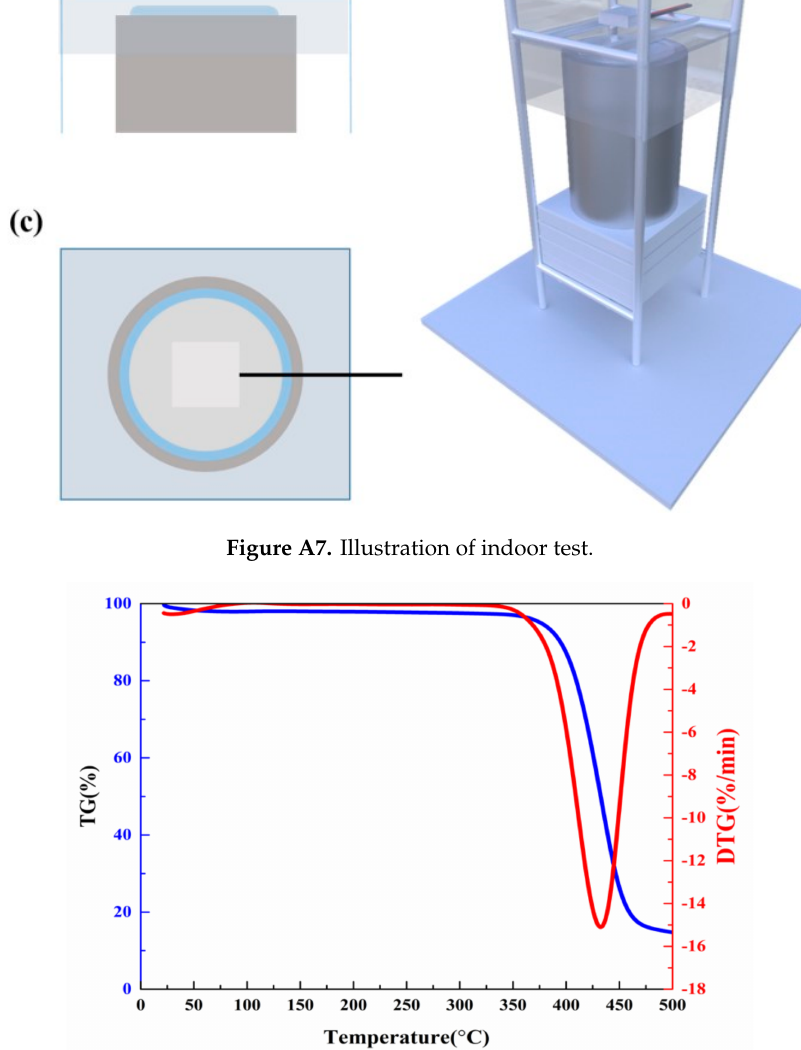
Figure A8. The thermal stability of the PAIP. The blue line corresponds to mass loss ratio of the PAIP sample and the red line corresponds to derivatives of mass loss ratio of the PAIP sample.